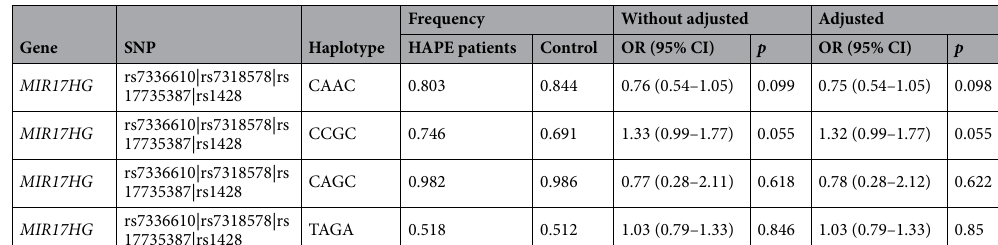
Table 6. The haplotype analysis result of MIR17HG polymorphisms and their associations with HAPE risk. SNP single-nucleotide polymorphism, OR odds ratio, 95% CI 95% confidence interval. p value was calculated by Wald test with and without adjusted by age and gender. p < 0.05 means the data is statistically significant.